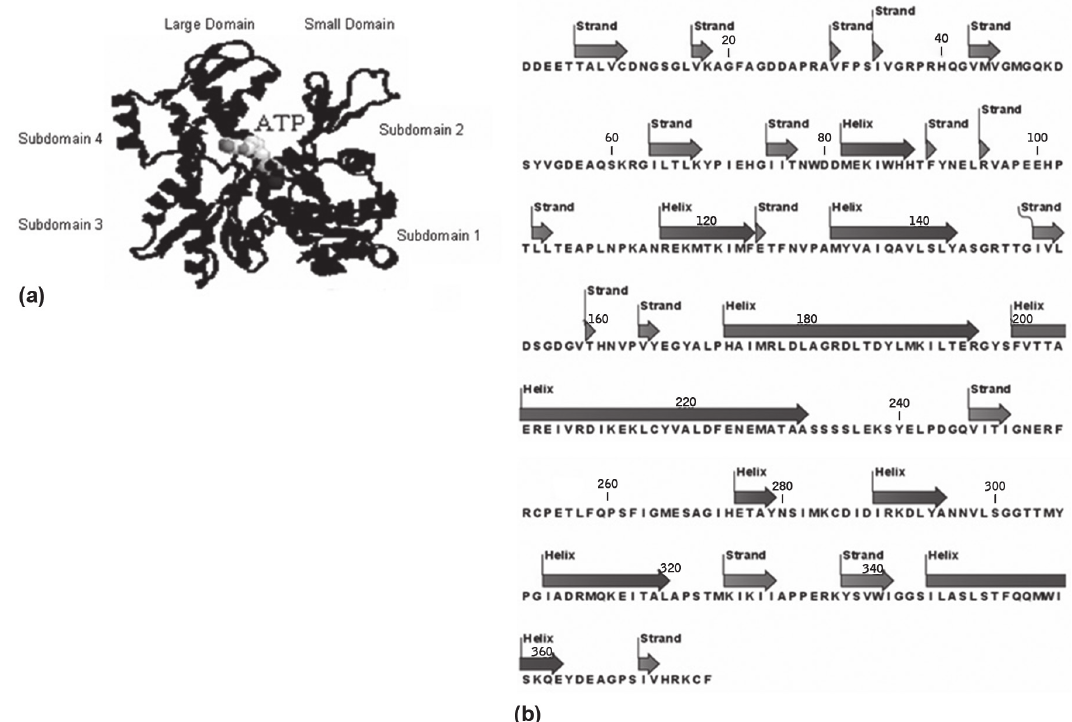
Figure 3 - Actin monomer (G-actin) tridimensional structure. ( a ) the small subdomain (composed of subdomains 1 and 2), the large subdomain (composed of subdomains 3 and 4), and the ATP-binding site at the subdomain 3. The N and C termini are located in subdomain 1 (Wasko et al. 2007), with some modifications. ( b ) predicted secondary structure of the α-skeletal muscle actin-2 of Coryphaenoides acrolepis and Coryphaenoides cinereus (Morita 2000), evidencing the alpha helices and the beta strand